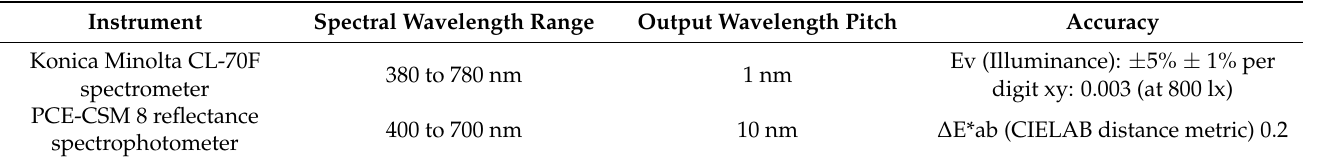
Table 1. Properties of the equipment used for this